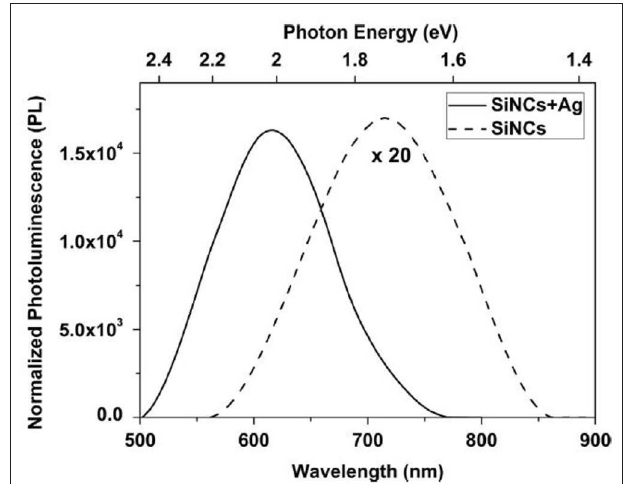
FIGURE 5 | Photoluminescence spectra of only silicon nanocrystals (dashed line) and silicon nanocrystals with Ag particles deposited on the silicon surface (solid line). The latter case shows an increase of the luminescence intensity as well as a blue shift of the spectrum of about 100nm. Gardelis et al. [58], Elsevier by